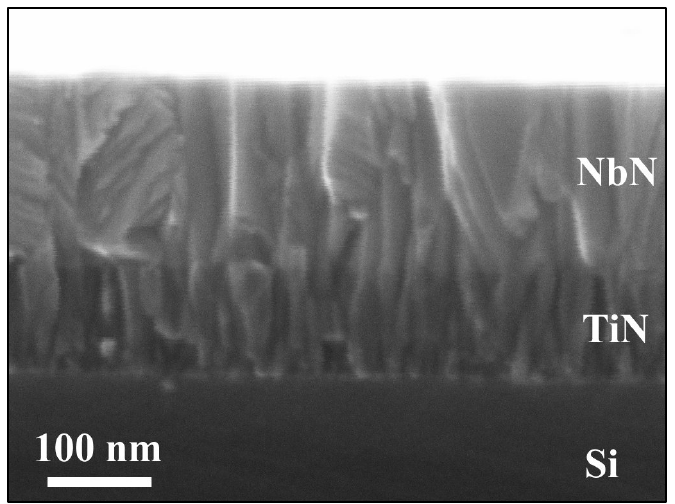
Figure 3. SEM image of a cross-section of a NbN-TiN heterostructure on a Si (001) substrate. The image was recorded with the sample broken parallel to a Si (110) plane perpendicular to the film surface.